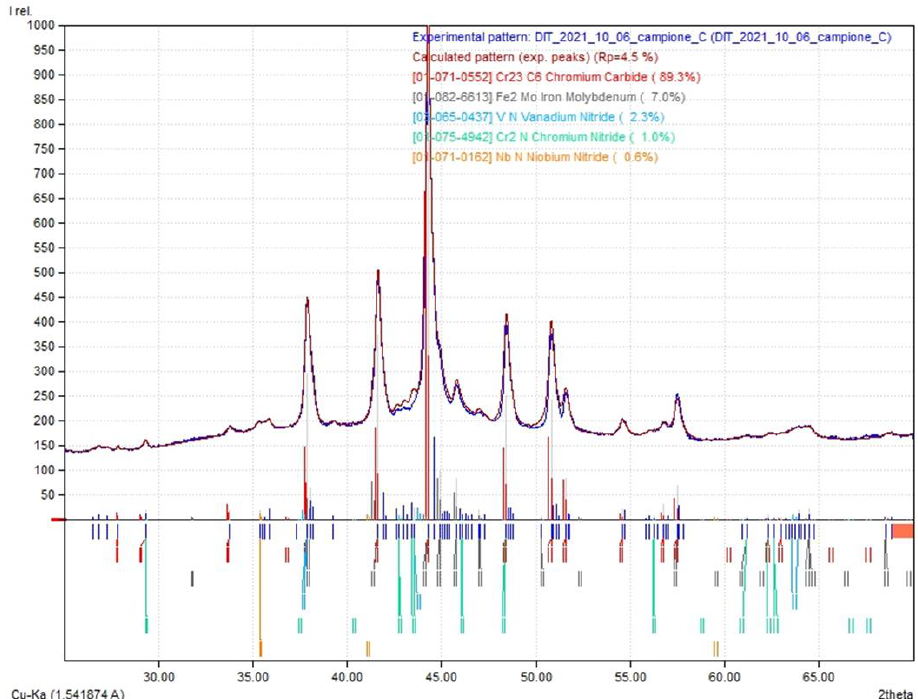
Figure A6. Failed crept cross-weld specimen 91-HAZ-3-6 600 °C 99 MPa 4280 h (sample C). XRD analysis.